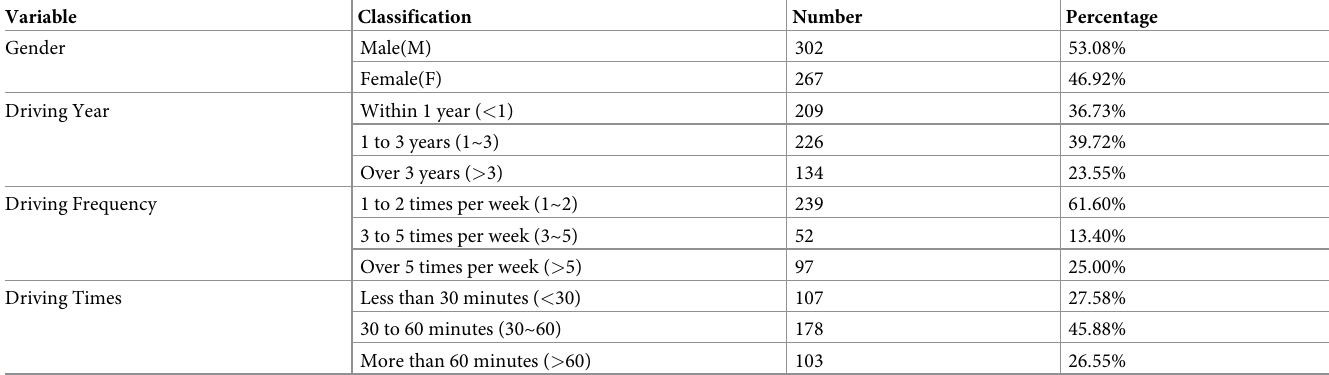
Table 1. Demographics information of participants.